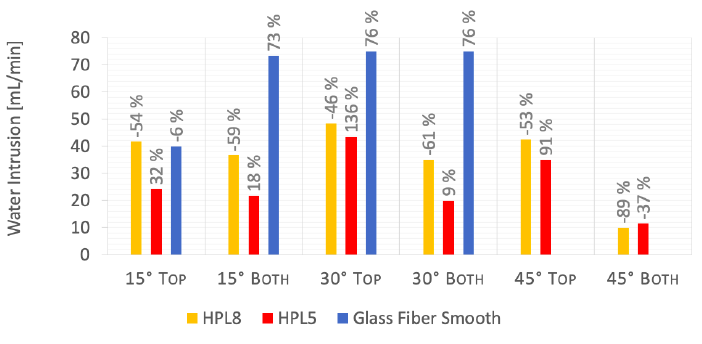
Figure 12. Water intrusion to the wind barrier for HPL and Glass Fiber Smooth with different bevelled joint designs. HPL8 has a joint width of 8 mm, while HPL5 has a joint width of 5 mm. Bevelment degrees are 15 ◦ , 30 ◦ , and 45 ◦ . The percentage change from the water intrusion measured with the standard recommendations in Table 3 is shown.